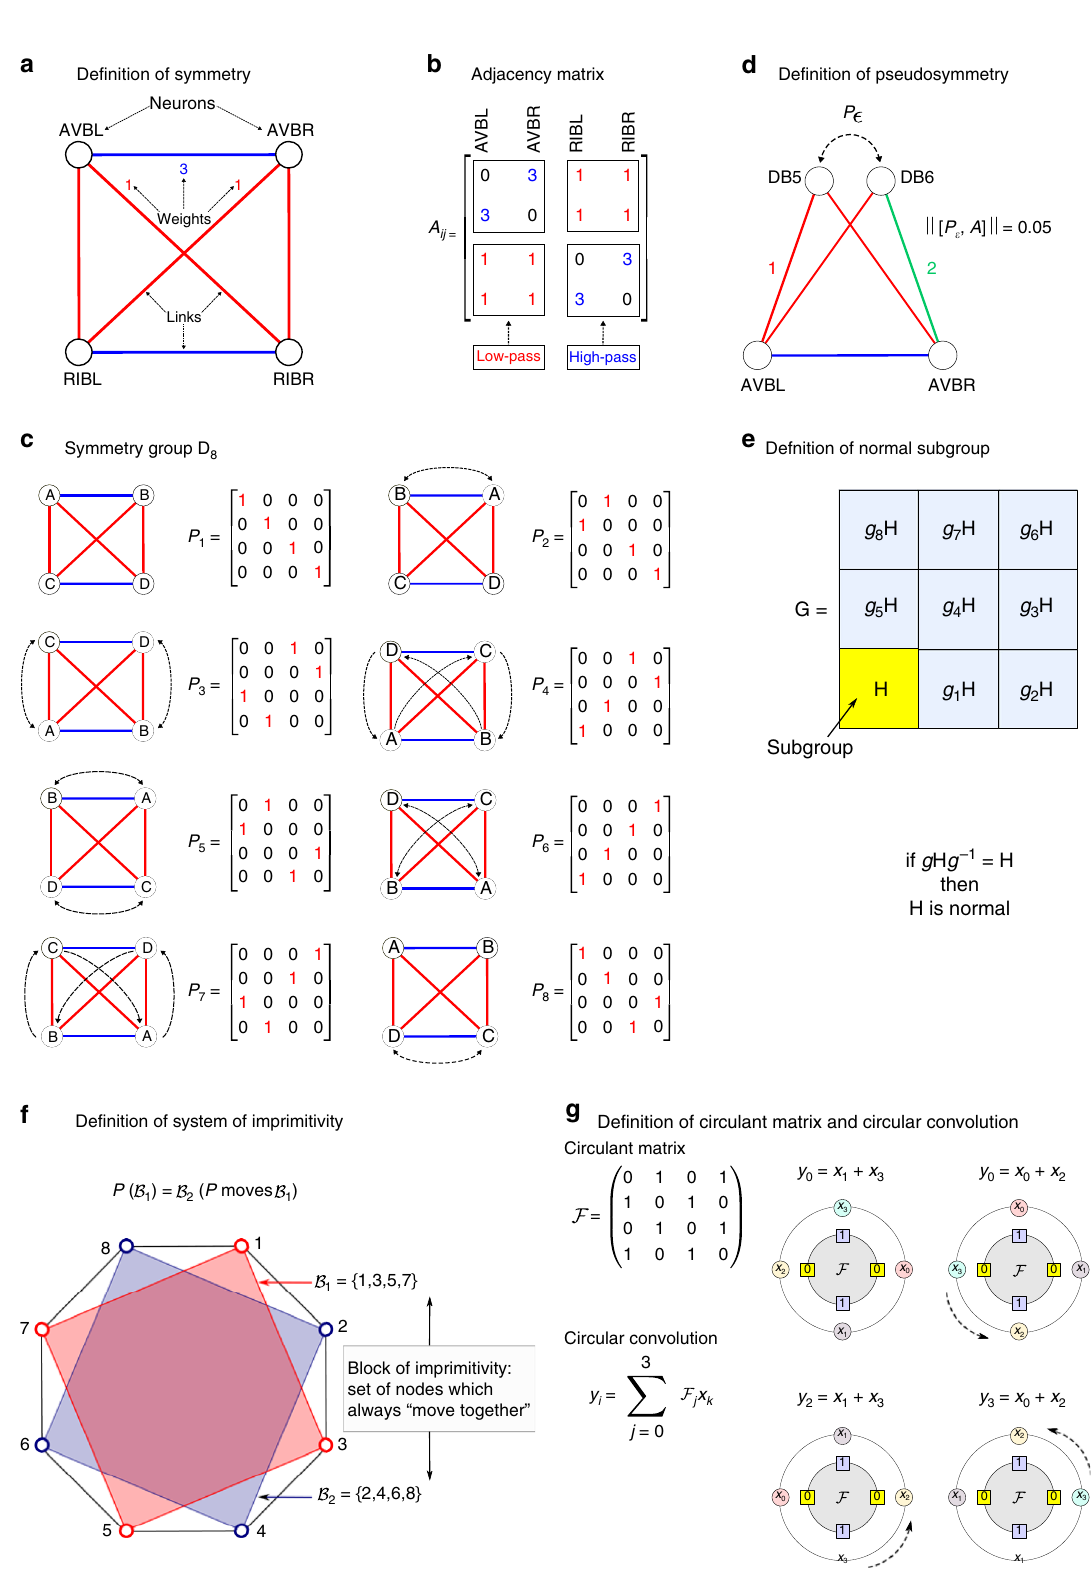
Fig. 1a, the de fi nition of pseudosymmetry depends on an additional parameter, a small number ε > 0. This parameter quanti fi es the uncertainty in the connectivity structure of the connectome due to natural variations across animals, and, thus, we call it the ‘ uncertainty constant ’ of the connectome. A pseudosymmetry is an approximate automorphism P ε , in